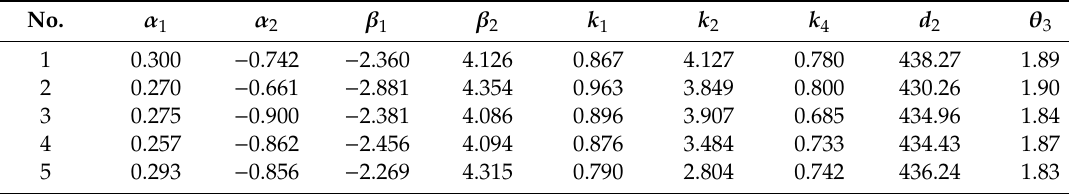
Table 3. Initial structures parameters obtained for the off-axis four-mirror system.